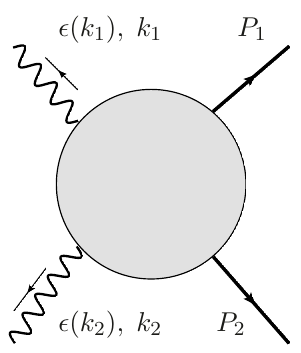
Figure 9 . Generic γ ( k 1 ) γ ( k 2 )